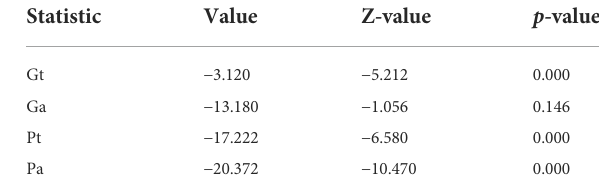
TABLE 6 Cointegration results for Westerlund (2007) test.